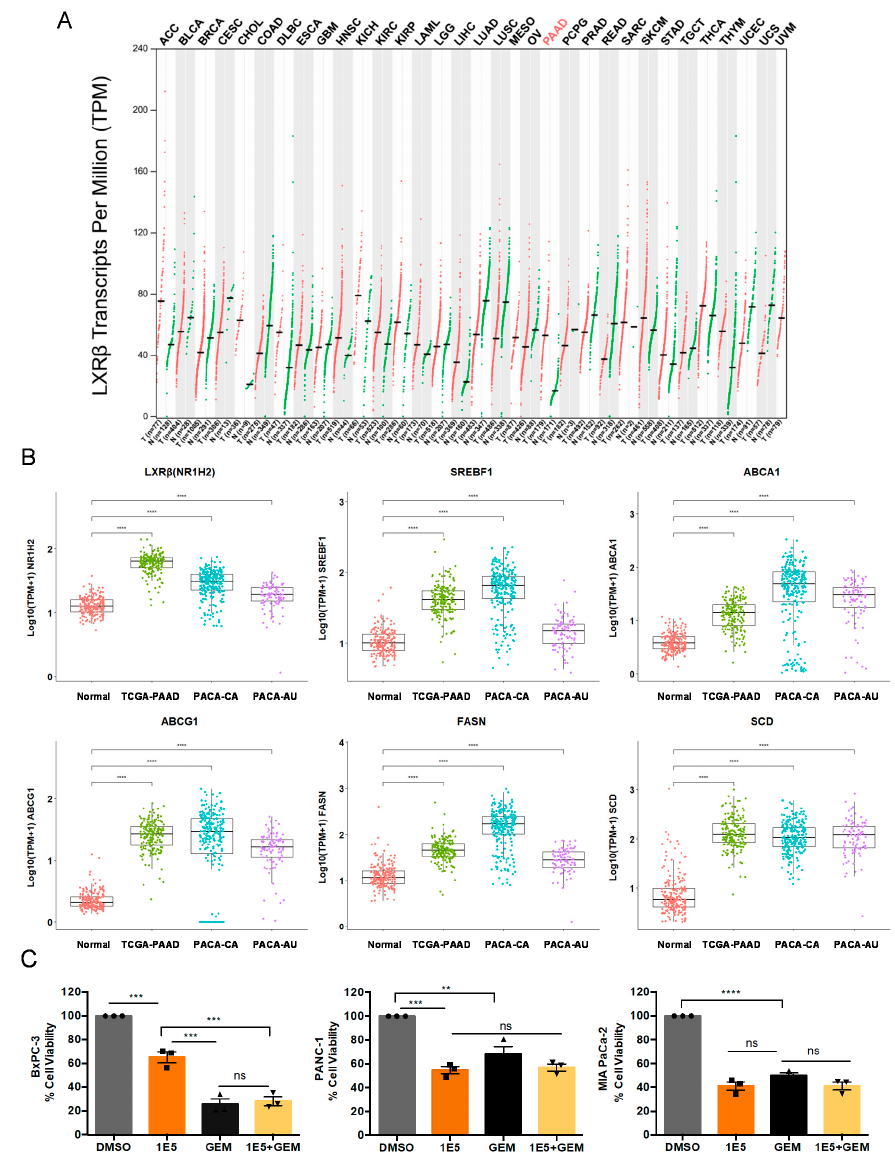
Figure 1. Pancreatic cancer cells overexpress LXR β and are vulnerable to novel liver X receptor (LXR) modulators that function as inverse agonists and degraders. ( A ) Transcripts per million (TPM) of LXR β was plotted for 33 different TCGA cohorts and their corresponding normal tissues. While LXR β showed differential expression in a number of cancers, only the overexpression in pancreatic cancer cohort (PAAD) was statistically significant. ( B ) Log-normalized TPM expression of LXR β and known target genes SREBF1 , ABCA1 , ABCG1 , FASN , and SCD from three cancer cohorts, namely The Cancer Genome Atlas-Pancreatic Adenocarcinoma (TCGA-PAAD), Pancreatic Cancer-Canada (PACA-CA), and Pancreatic Cancer-Australia (PACA-AU), were compared to normal pancreatic tissues from The Genotype-Tissue Expression Project (GTEx) and all consistently showed overexpression in tumors as compared to normal tissues. ( C ) Treatment with novel LXR ligand 1E5 elicits antiproliferative response in pancreatic ductal adenocarcinoma (PDAC) cells. MTT assay of PDAC cells treated with DMSO, 1E5 (10 µ M), gemcitabine (20 nM in BxPC-3, 40 nM in PANC-1 and MIA PaCa-2 cells), and 1E5 + Gem (5 µ